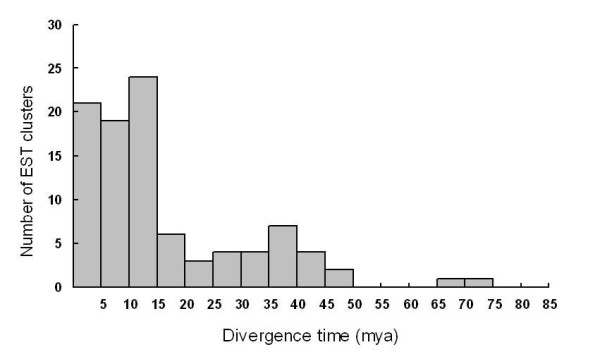
Distribution of divergence time. X axis is the divergence time (mya) of homologous pairs, Y axis is the number of detected EST clusters.